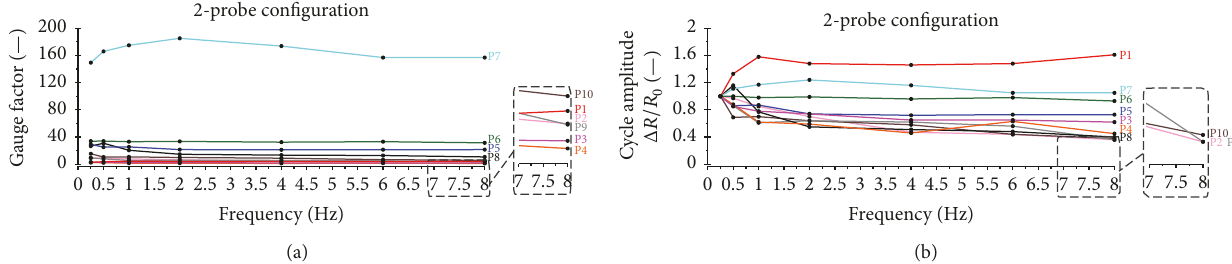
Figure 9: Plots of GFs (a) and of normalized resistance variation (b) with increasing frequency of applied load using the two-probe